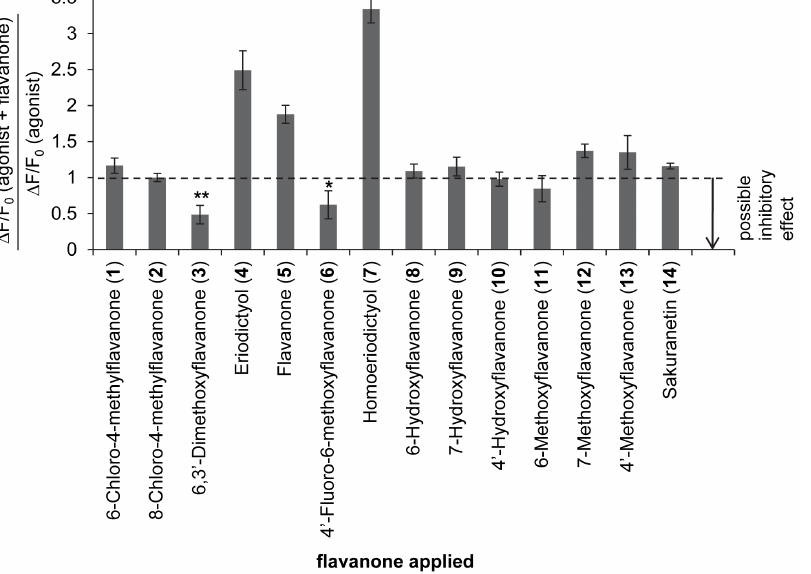
D F = F 0 ( agonist z flavanone ) v 1 . Data are D F = F 0 ( agonist )